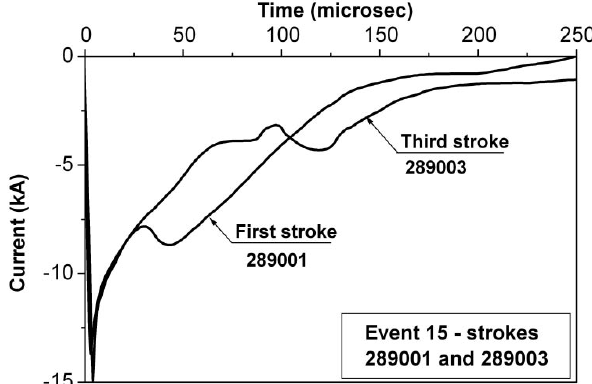
Fig. 1. The first three strokes of a negative downward 5-stroke mul- tiple flash obtained at MC (event 13).